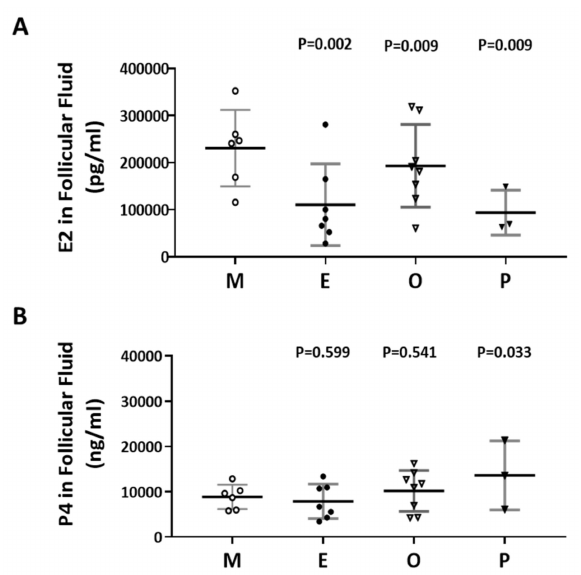
Figure 5. Comparison of the levels of E2 and P4 in the follicular fluid of the various infertile groups. ( A ) E2 content in the follicular fluid. ( B ) P4 content in the follicular fluid. The follicular fluid of the patient was collected, and the contents of E2 (pg / mL) and P4 (ng / mL) in the follicular fluid were analyzed by radioimmunoassay (RIA). The p -value for each group versus the male factor group was determined by an unpaired t